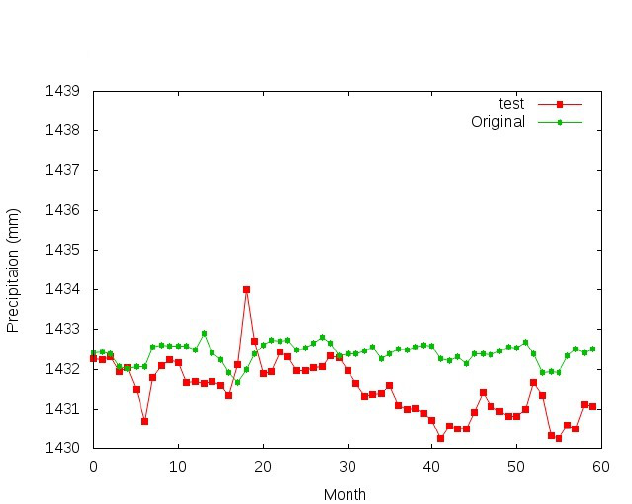
Fig. 8: Result under 200 hidden units and x 2 + x